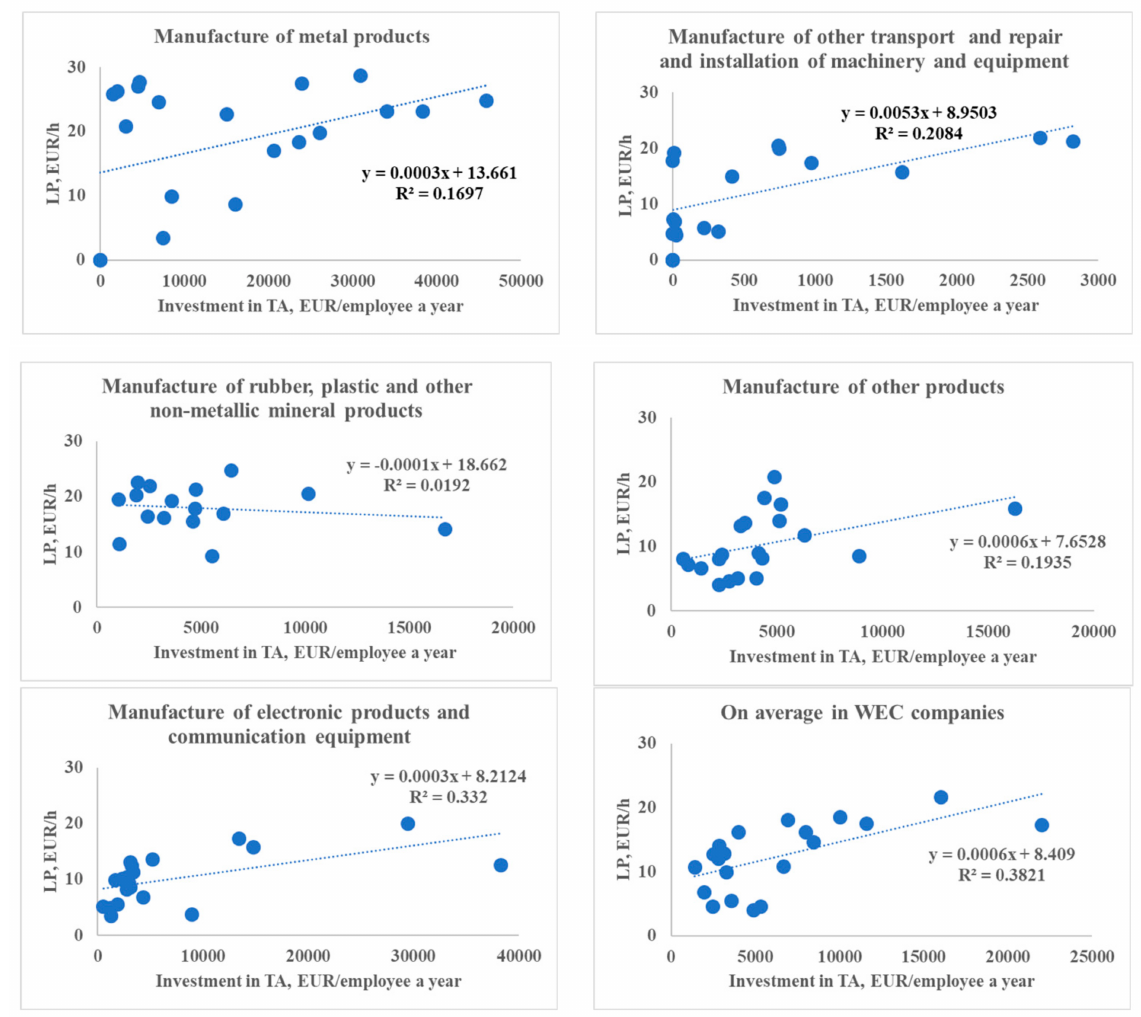
Figure 17. Interdependence of investment in tangible assets and labour productivity during 2000– 2020 (own